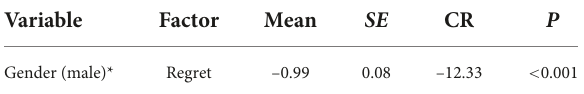
TABLE 5 Gender latent mean